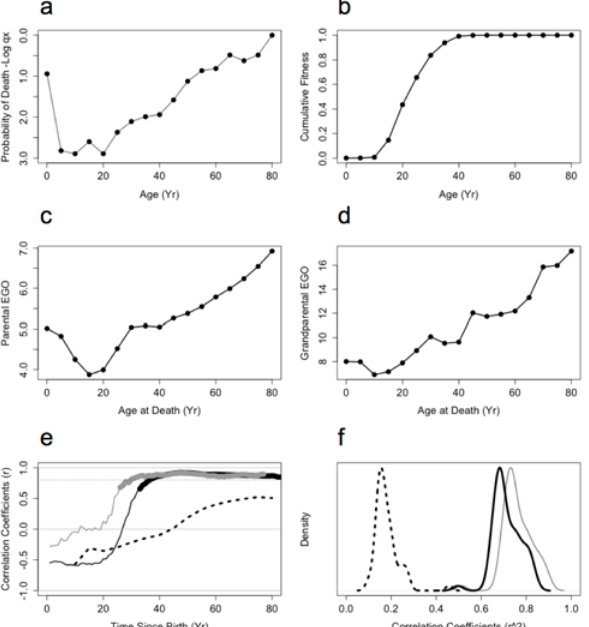
Figure 2. Comparison of Agta mortality profiles predicted by ELe and EGO. (a) Age-specific probability of mortality qx . (b) Mortality profile predicted by ELe. (c) Mortality profile predicted by parental EGO. (d) Mortality profile predicted by grandparental EGO. (e) Correlation coefficient between qx and ELe (dashed line), parental EGO (black line) and grandparental EGO (grey line) across a range of census times. Heavy lines indicate p < 0.01. (f) Distributions of correlation coefficients between qx profiles of 59 UN populations and the ELe values calculated directly from these populations (dashed line), and Agta-derived parental (black solid line) and grandparental (grey line) EGO